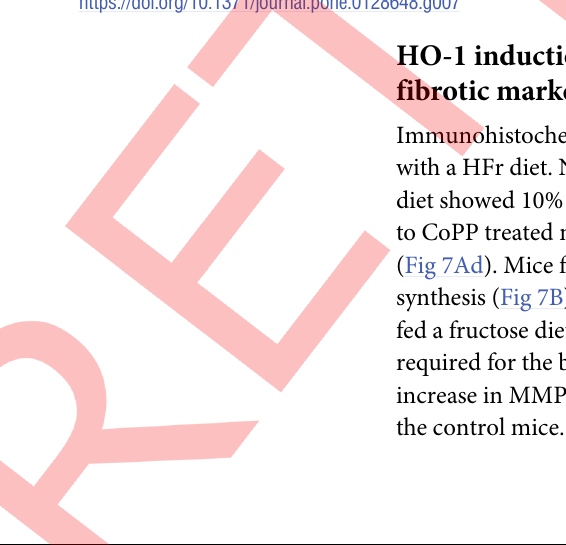
PLOS ONE | https://doi.org/10.1371/journal.pone.0128648 June 22,